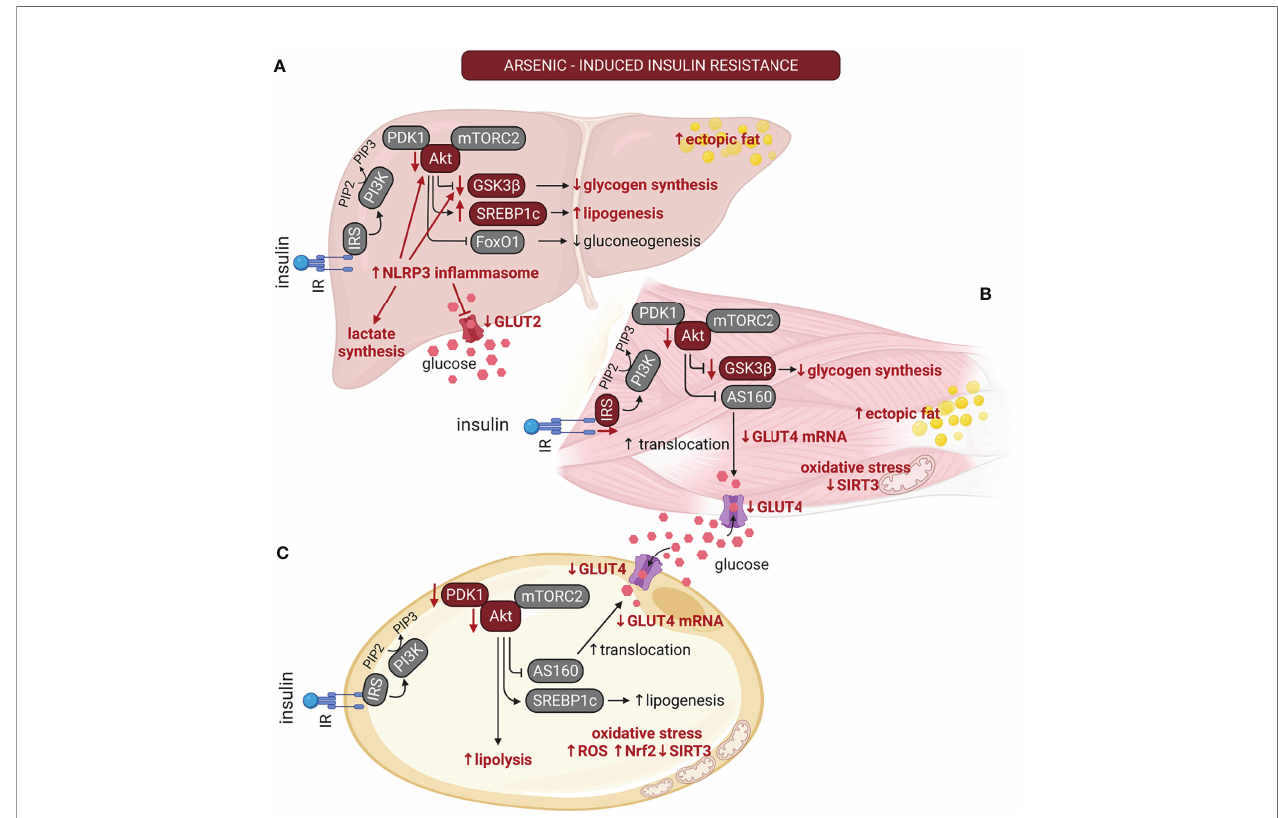
FIGURE 2 | The multiple effects of arsenic on insulin signaling are tissue-dependent. The alterations induced by arsenic exposure on the insulin signaling pathway are depicted with red font. Arsenic induces insulin resistance in classical insulin targeted organs. (A) In liver, arsenic reduces GLUT2 protein levels and reduces glycogen synthesis due to NLR family pyrin domain containing 3 (NLRP3) in fl ammasome activation. This also results in reduction in the phosphorylation of Akt and glycogen synthase kinase 3 b (GSK3 b ). Also, it promotes liver lipogenesis and the development of non-alcoholic fatty liver disease (NAFLD). (B) In muscle, arsenic inhibits GLUT4 expression. It also reduces insulin signaling by inhibiting IRS-1 and Akt phosphorylation, reducing insulin-stimulated GLUT4 translocation and decreased glycogen levels, thus contributing to hyperglycemia in the postprandial state. Arsenic can also promote ectopic fat deposition in muscle. (C) In adipose tissue, this pollutant induces adipocyte hypertrophy, impaired adipogenesis, and suppression of mitochondrial biogenesis. Arsenic stimulates lipolysis, and oxidative stress due to reduced SIRT3 activity. On the other hand, it inhibits GLUT4 expression and insulin-stimulated GLUT4 translocation by inhibition of Akt phosphorylation. Akt, protein kinase B; AS160, Akt substrate 160 kDa; FoxO1, forkhead-box-O1; GLUT4, glucose transporter 4; GSK3 b , glycogen synthase kinase 3 b ; IR, insulin receptor; IRS, insulin receptor substrate; mTORC2, mammalian target of rapamycin complex 2; NLRP3, NLR family pyrin domain containing 3; Nrf2, nuclear factor erythroid 2-related factor 2; PDK1, Phosphoinositide-dependent kinase-1; PI3K, phosphatidyl inositol 3 kinase; PIP2, phosphatidyl inositol 4;5-biphosphate; PIP3, phosphatidyl inositol 3;4;5 triphosphate; ROS, reactive oxygen species; SIRT3, sirtuin-3; SREBP1c, sterol regulatory element-binding transcription factor 1c. Created with